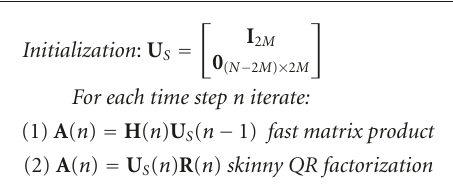
Algorithm 1: Sequential iteration EVD